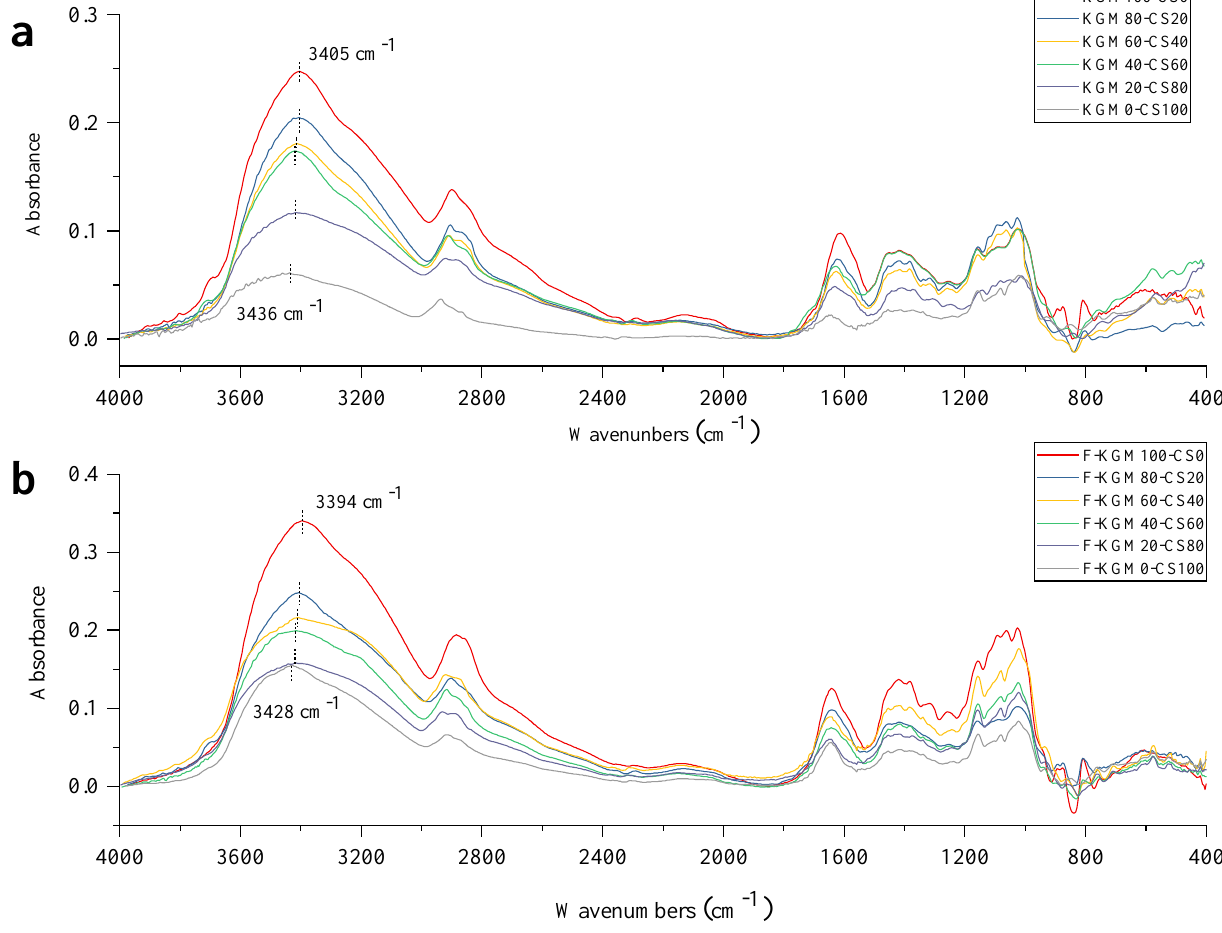
Figure 5. FT–IR spectra of the composite gels with different KGM/starch ratios: ( a ) KGM–CS gels; ( b ) F–KGM–CS gels.